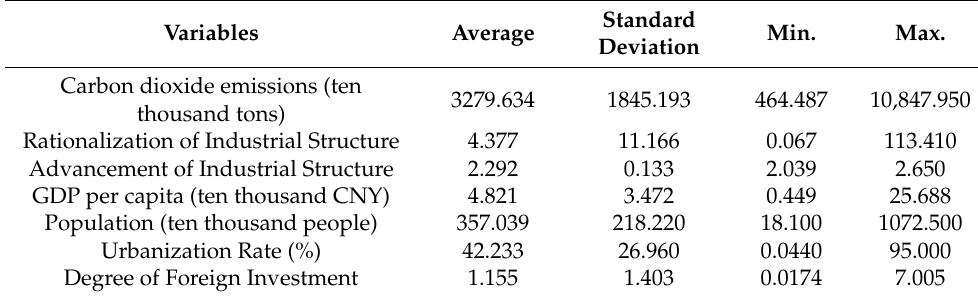
Table 2. Descriptive statistics of